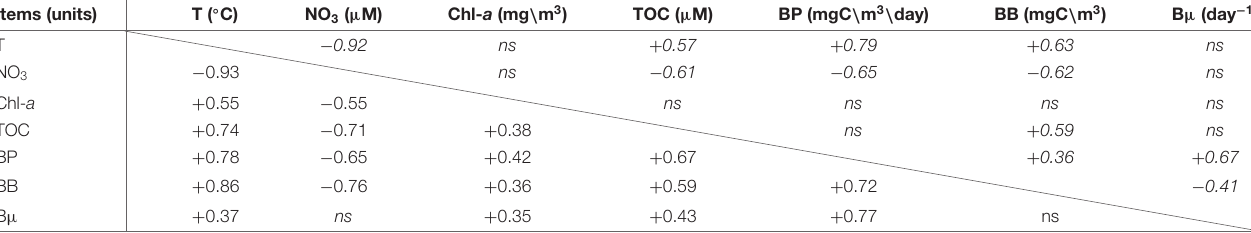
TABLE 1 | Correlation matrix for measurements collected from stations 6 and 2 of the July cruise. Items (units)